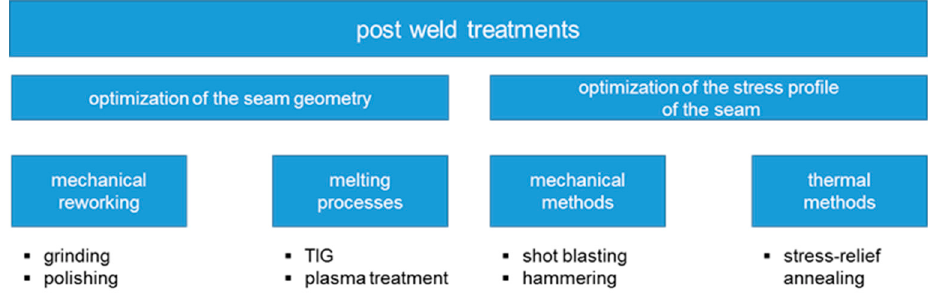
Figure 2. Classification of post weld treatments.